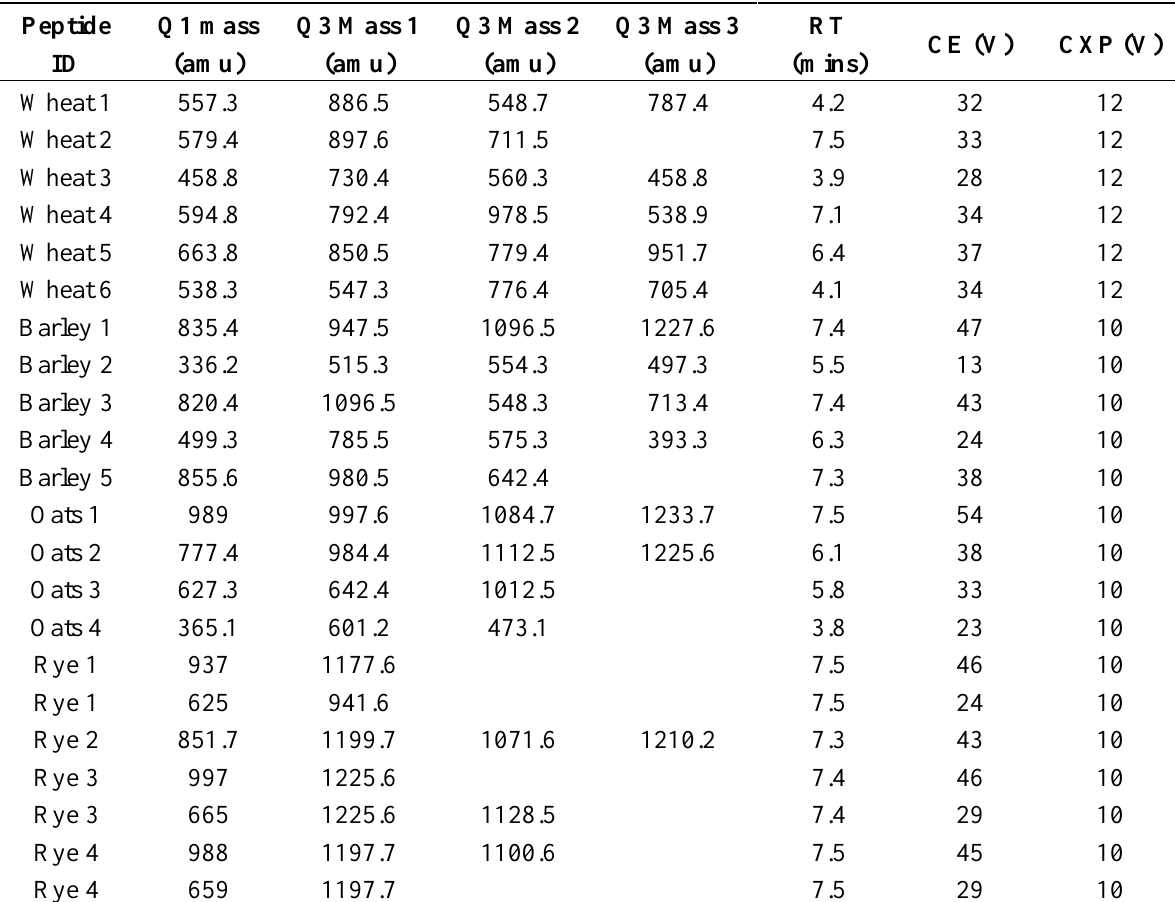
Table 2. MRM transitions used for triggers for generating EPI spectra and peptide